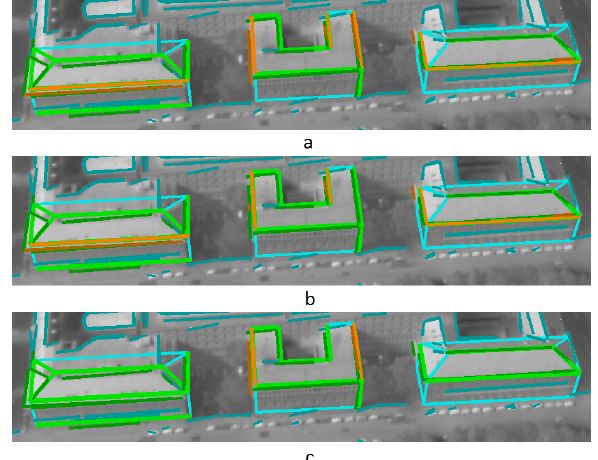
Figure 2: Results on outlier detection in the frame no. 13209: a) outliers detected based on analysis of parameters of model points; b) outliers detected based on analysis of parameters of im- age lines; c) outliers detected based on analysis of all parameters. Color coding: dark cyan - detected image line segments with- out correspondences, bright cyan - projected model edges without correspondences, dark green - detected image line segments with correspondences, bright green - projected model edges with cor- respondences, dark orange - detected image line segments with correspondences detected as outliers, bright green - projected model edges with correspondences detected as outliers